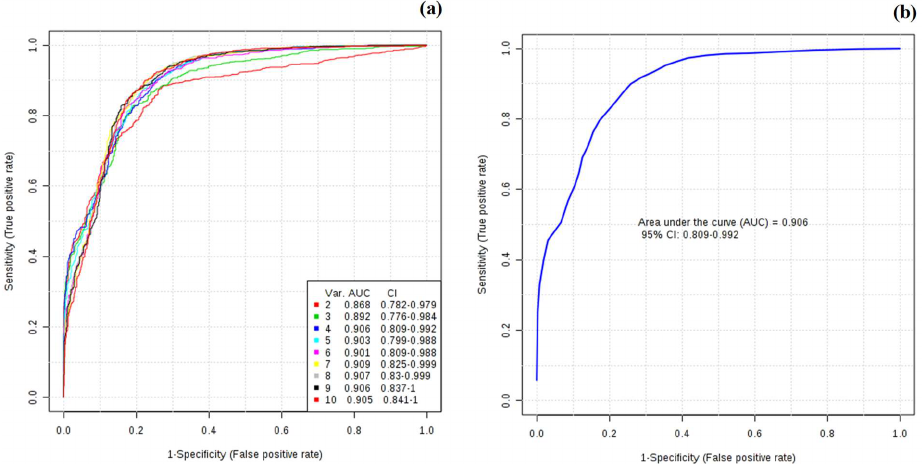
Figure 5. Receiver operating characteristic (ROC) curves for the predictive model. ( a ) A combination model calculated from the logistic regression analysis using the 10 metabolites selected by the VIP (>1.0) values, ( b ) ROC curves for the top 4 metabolites (creatine, glycine, trimethylamine N-oxide, and serine) with the highest ability to discriminate BC patients against